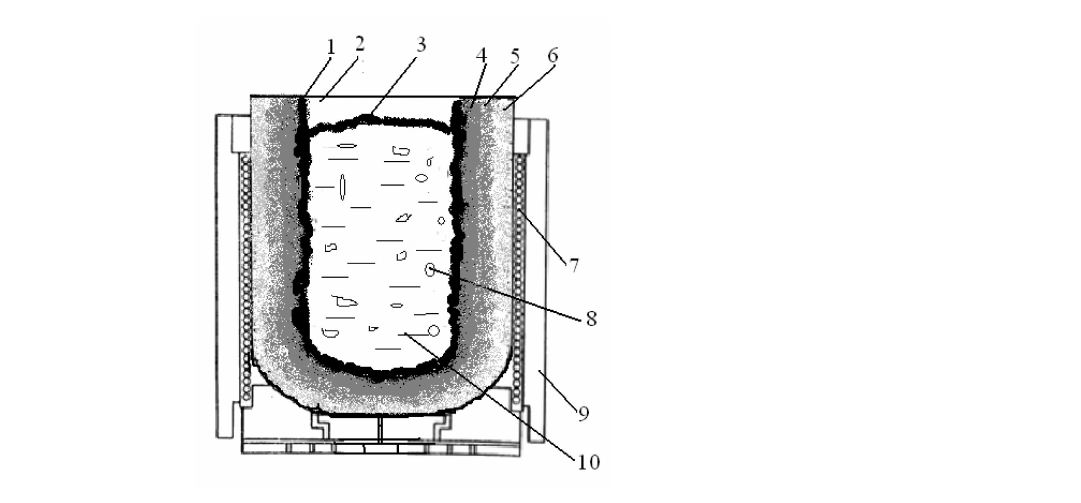
Figure 3. Diagram of the location of quartzite lining areas in the IRT furnace: 1—coated sintered lining layer; 2—gas phase on the melt surface; 3—liquid slag on the melt surface; 4—sintered layer; 5—semi-welded layer; 6—layer of unsteady mass (buffer); 7—inductor; 8—gas contained in the melt itself; 9—furnace housing;